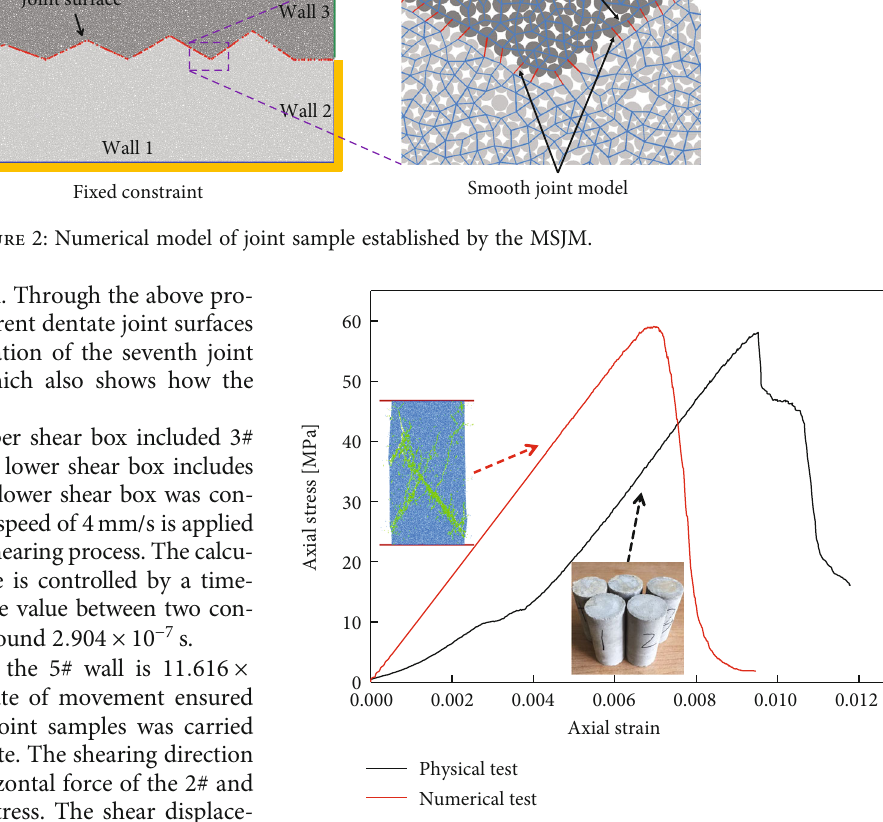
Figure 3: Uniaxial compression test results of intact rock. Table 1: Microscopic parameters of balls and bonds in the